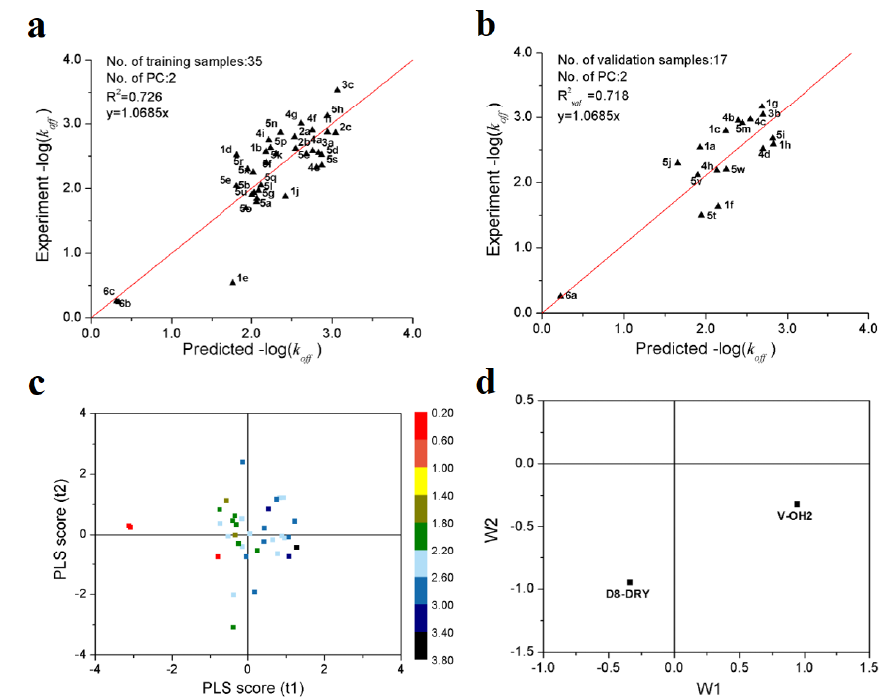
Figure 1. PLS modeling results of the dissociation rate constants of 52 Hsp90 inhibitors. ( a ) scatter plot of experimental vs. predicted −log( k off ) of 35 training samples; ( b ) scatter plot of experimental vs. predicted −log( k off ) of 17 validation samples; ( c ) first two principle component scores. The color legend represents the range of −log( k off ) values; ( d ) loading plot of the first two principal components.